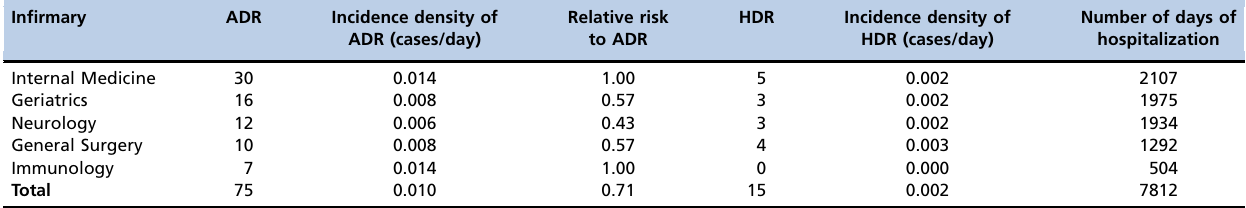
Table 3 - Incidence density of ADR and HDR by medical